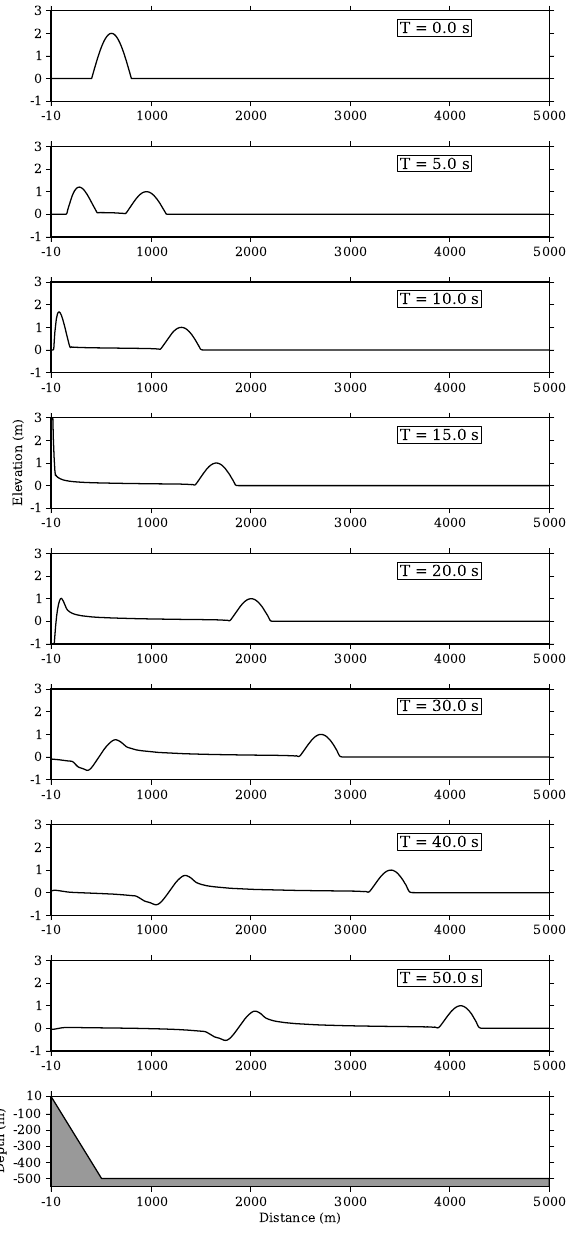
Fig. 13. Benchmark 3: propagation of a positive plane wave over a flat channel ending with a constant-slope beach.